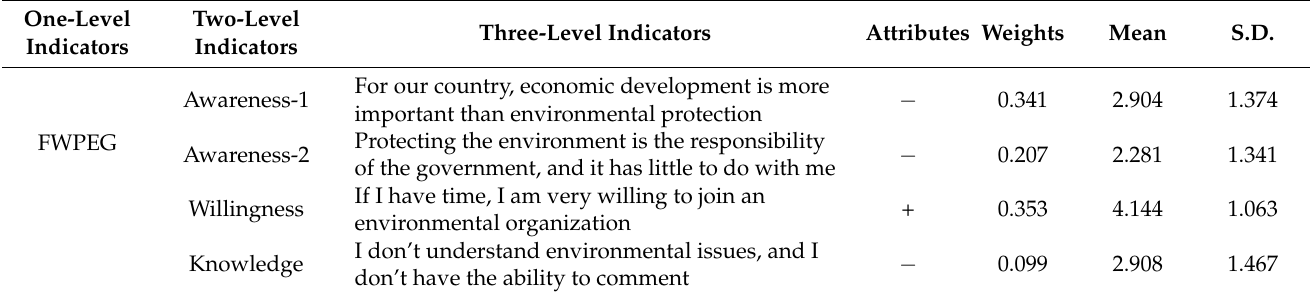
Table 1. Evaluation index system of farmers’ willingness to participate in environmental governance.